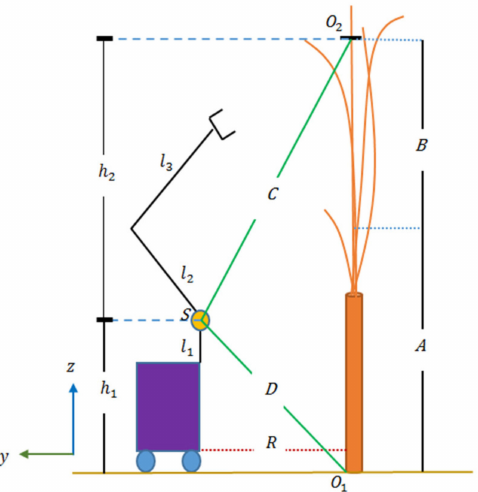
Figure 3. Robot winter cane pruning task space in the yz